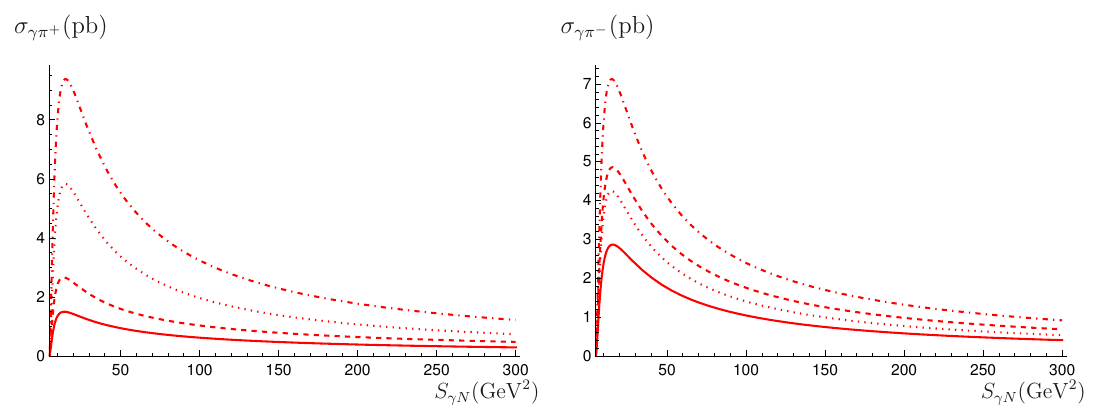
Figure 17 . The integrated cross-section for π + ( π − ) is shown as a function of S γN on the left (right). The dashed (non-dashed) lines correspond to holographic (asymptotic) DA, while the dotted (non-dotted) lines correspond to the standard (valence) scenario. We thus find that the maximum cross-section appears at around 20 GeV 2 , a feature which was not totally clear in figure 7.